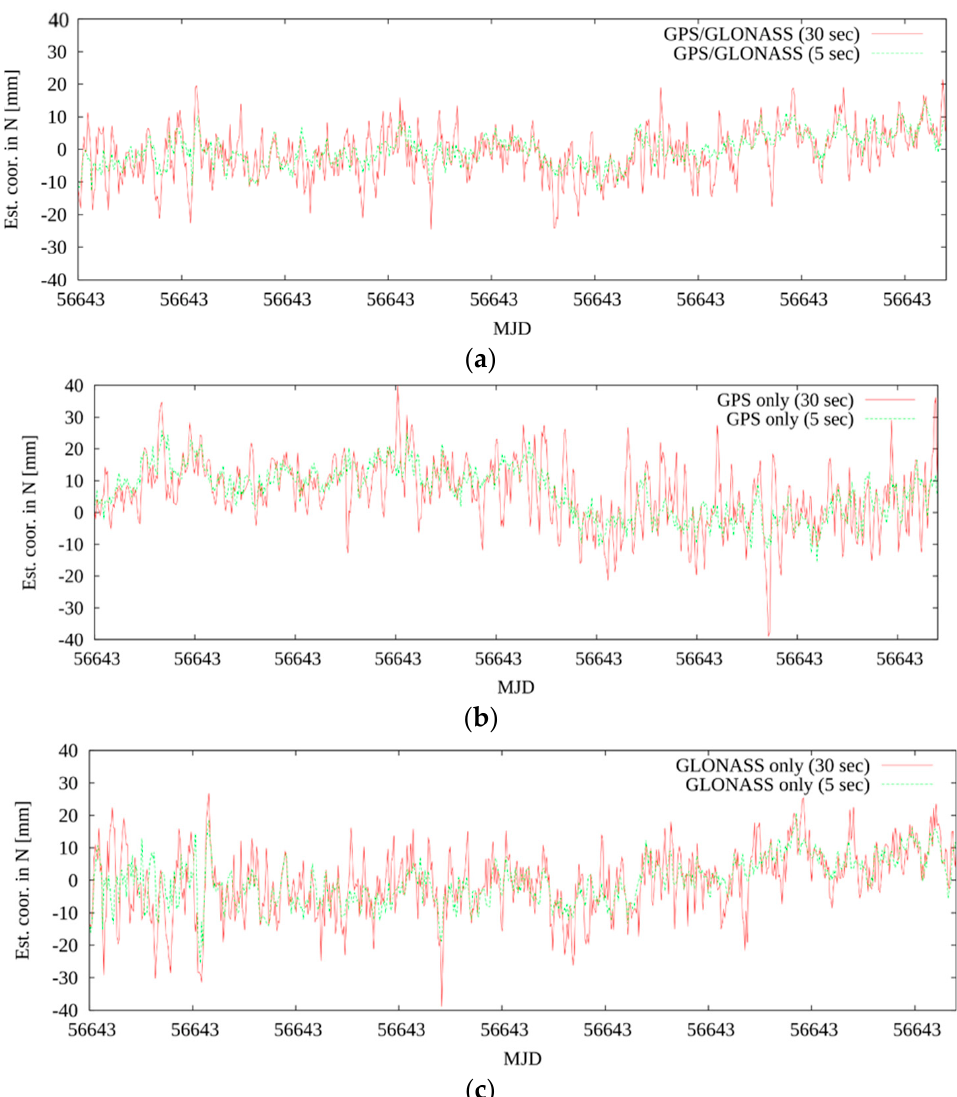
Figure 11. ( a ) Estimated kinematic coordinates in the north for two different sampling types, referring to the GPS+GLONASS solution. ( b ) Estimated kinematic coordinates in the north for two different sampling types, referring to the GPS solution. ( c ) Estimated kinematic coordinates in the north for two different sampling types, referring to the GLONASS solution. All three solutions refer to the first hour on December 17, 2013.